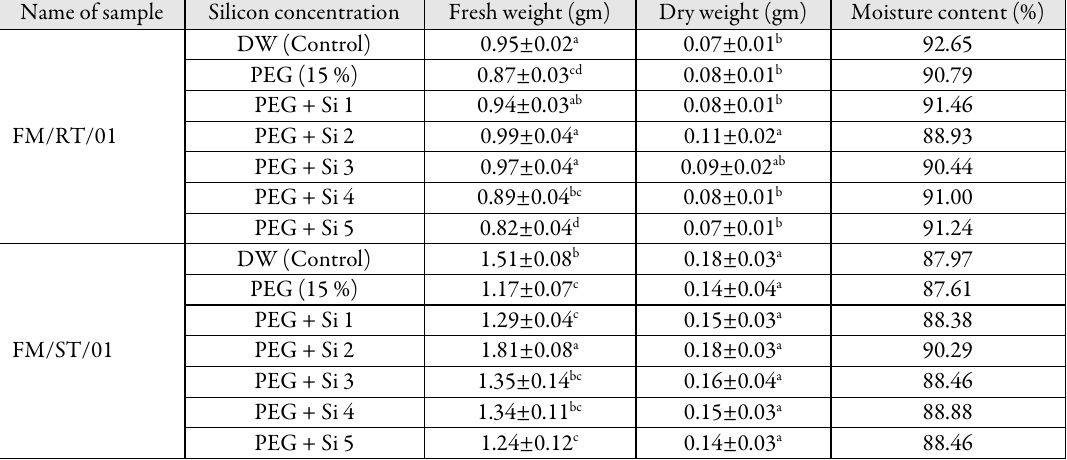
Table 2. Effect of Si on fresh weight, dry weight and moisture content in seedlings of local finger millet landraces under PEG-6000 induced osmotic